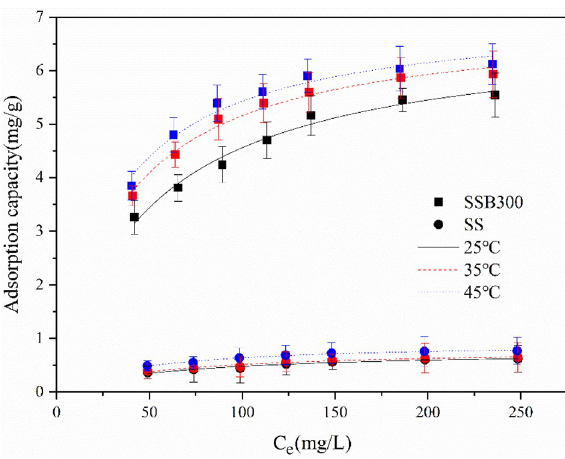
Figure 8. The adsorption thermodynamic isotherm of ammonium (Langmuir).